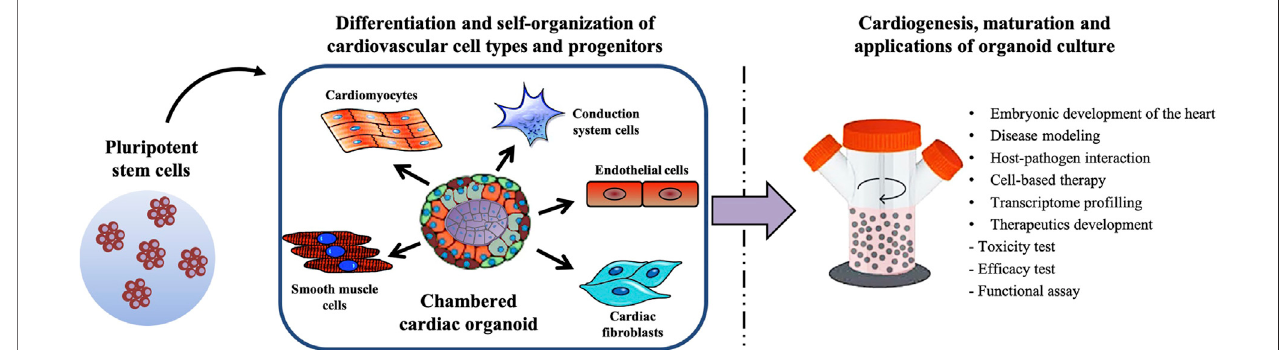
FIGURE 2 | Schematic summarizing the generation of a multicellular chambered cardiac organoid, and its maturation process and applications.